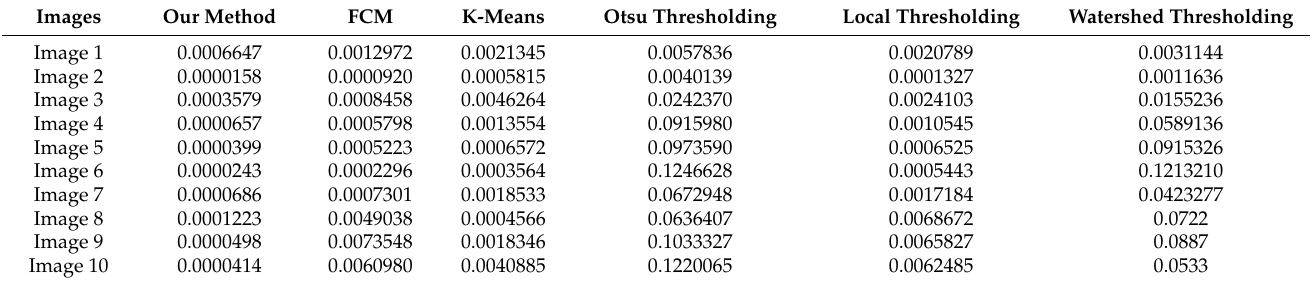
Table 8. Comparison between the results of our segmentation method on the KICA dataset and some well-known segmentation techniques using the RMSE metric.